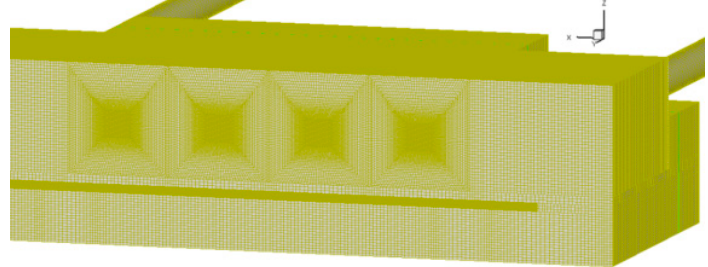
Figure 11. Schematic of block structured mesh from a partial-view image.